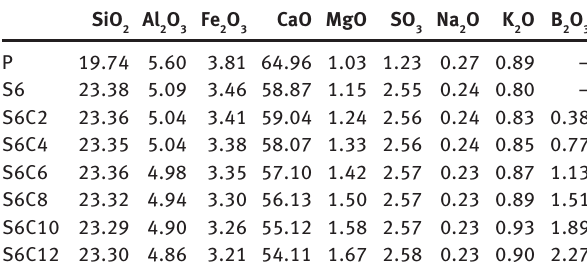
Table 6 Chemical analysis results of cement